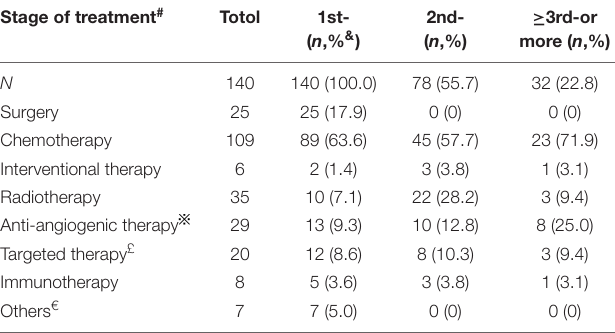
TABLE 2 | Initial and follow-up anti-cancer regimens for patients with ILD-LC. Stage of treatment #